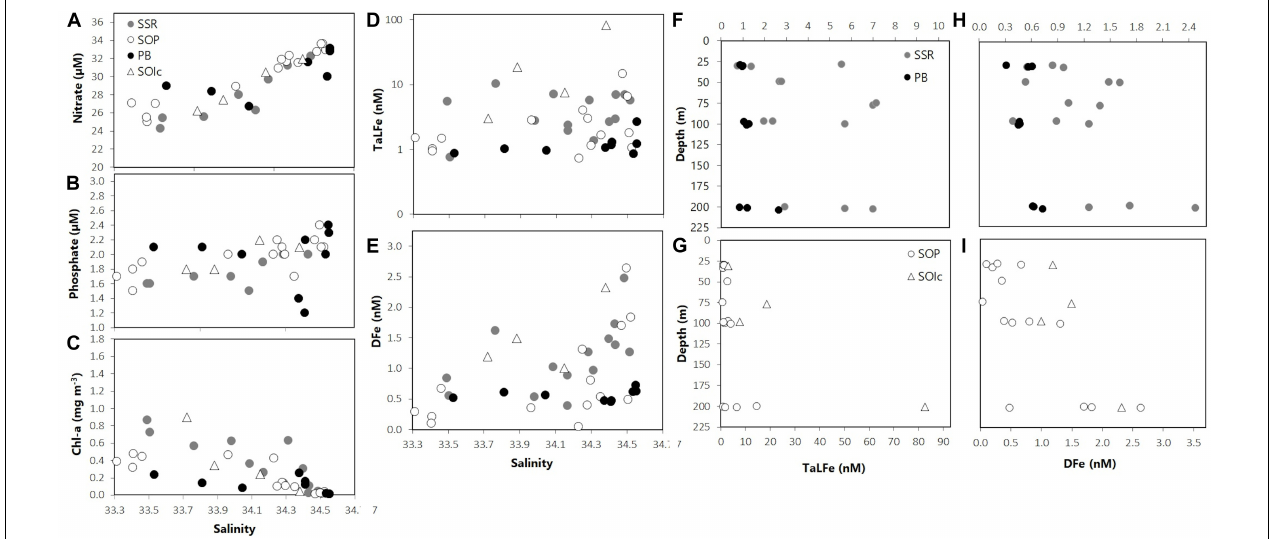
FIGURE 6 | (A) Nitrate ( µ M), (B) phosphate ( µ M), (C) Chl-a (mg m − 3 ), (D) TaLFe (nM), and (E) DFe (nM) distribution in relation to salinity; (F,G) TaLFe (nM) and (H,I) DFe (nM) distribution in relation to depth (m) for all groups of stations in the SOI 2008. Note logarithmic scale for D . SSR: South Scotia Ridge, SOP: South Orkney Plateau, PB: Powell Basin, SOIc: South Orkney Islands coastal.